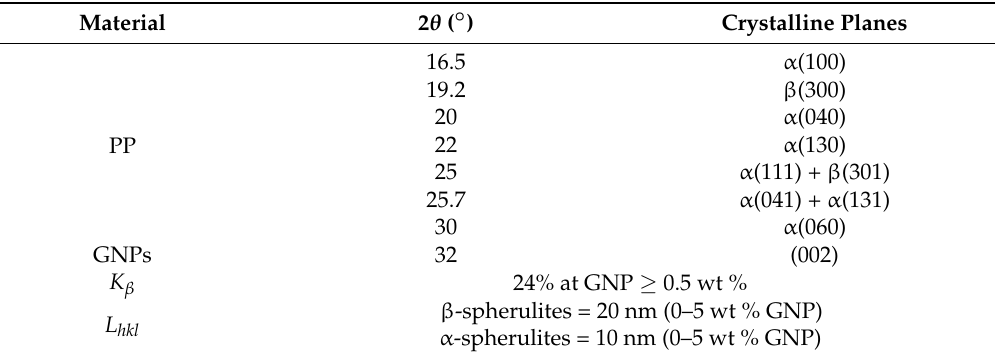
Table 2. X-ray diffraction (XRD) results